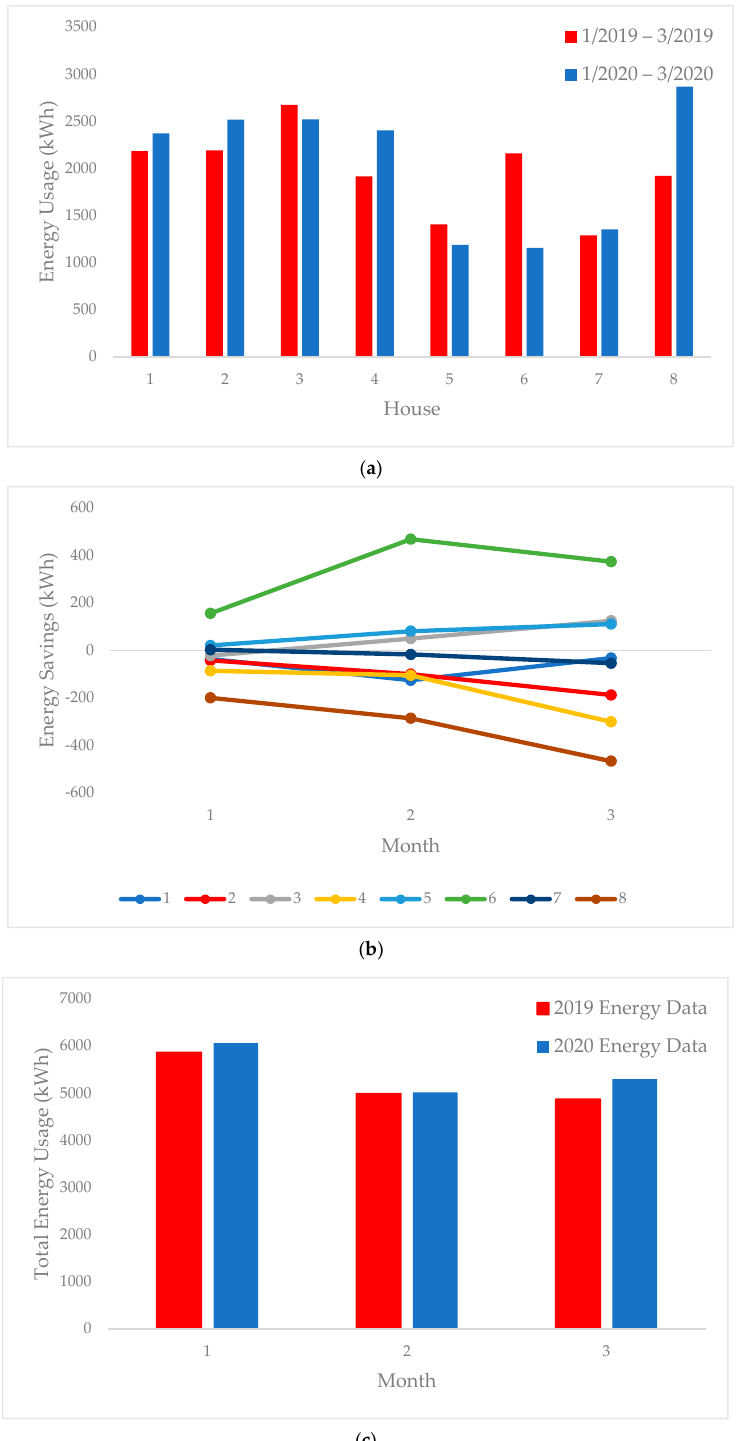
Figure 3. ( a ) Total household energy usage for 3-month period; ( b ) household energy savings (3-month period post-energy walkthrough); ( c ) total energy usage, 2019 and 2020 comparison. Summing the energy usage of all participating households, energy changes between households experienced an energy increase of 4.11% over the three-month period from